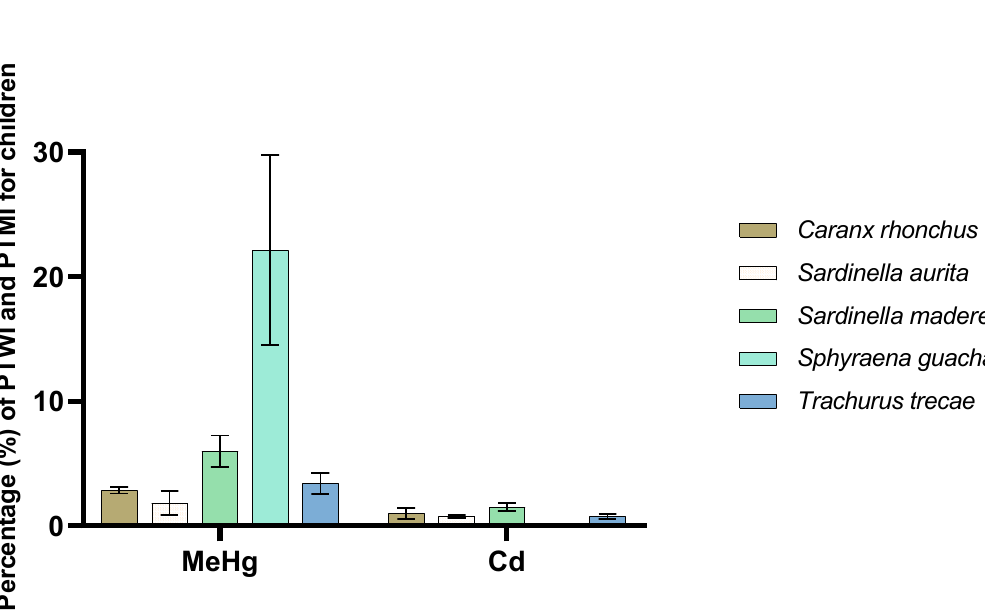
Figure 5. Potential consumer exposure to methylmercury (MeHg) and cadmium (Cd) for children when a portion of 25 g fish fillet is consumed one time per week and every day for a month for MeHg and Cd, respectively. The potential consumer exposure is compared to the provisional tolerable weekly intake (PTWI) for MeHg and provisional tolerable monthly intake (PTMI) for Cd, as set by the JECFA.